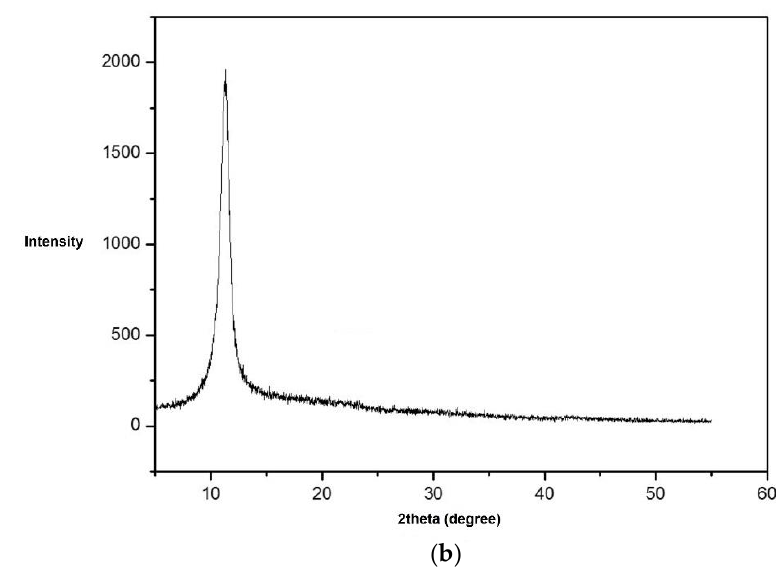
Figure 1. ( a ) Transmission electron microscope (TEM) image; and ( b ) X-ray diffraction (XRD) spectrum of graphene nanoplatelet.